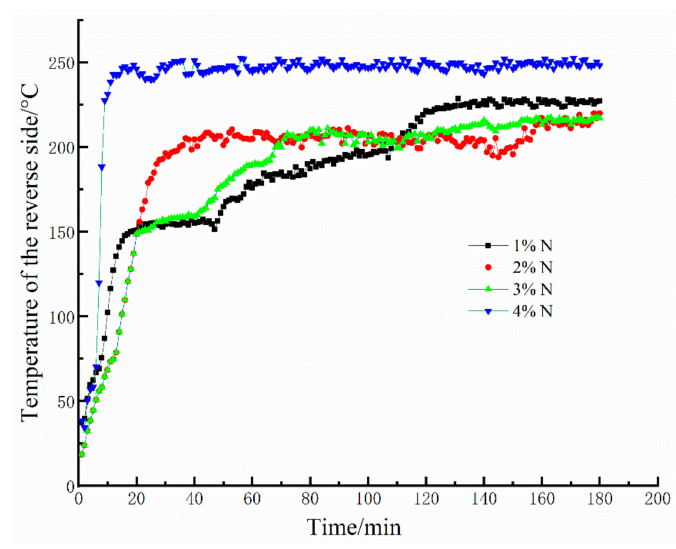
Figure 4. Fire-resistance test results of geopolymer foams.